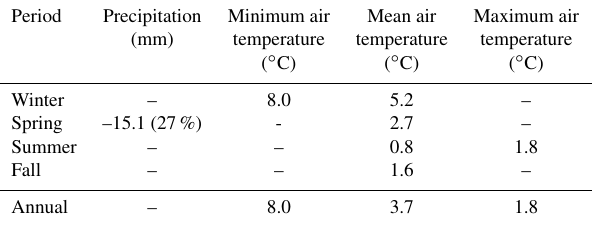
Table 1. Changes in precipitation and temperature for the pe- riod 1960–2016 and statistically significant trends at the p ≤ 0 . 05 significance threshold using the Mann–Kendall test. Changes in pre- cipitation as a percentage with respect to 1960 are also presented.